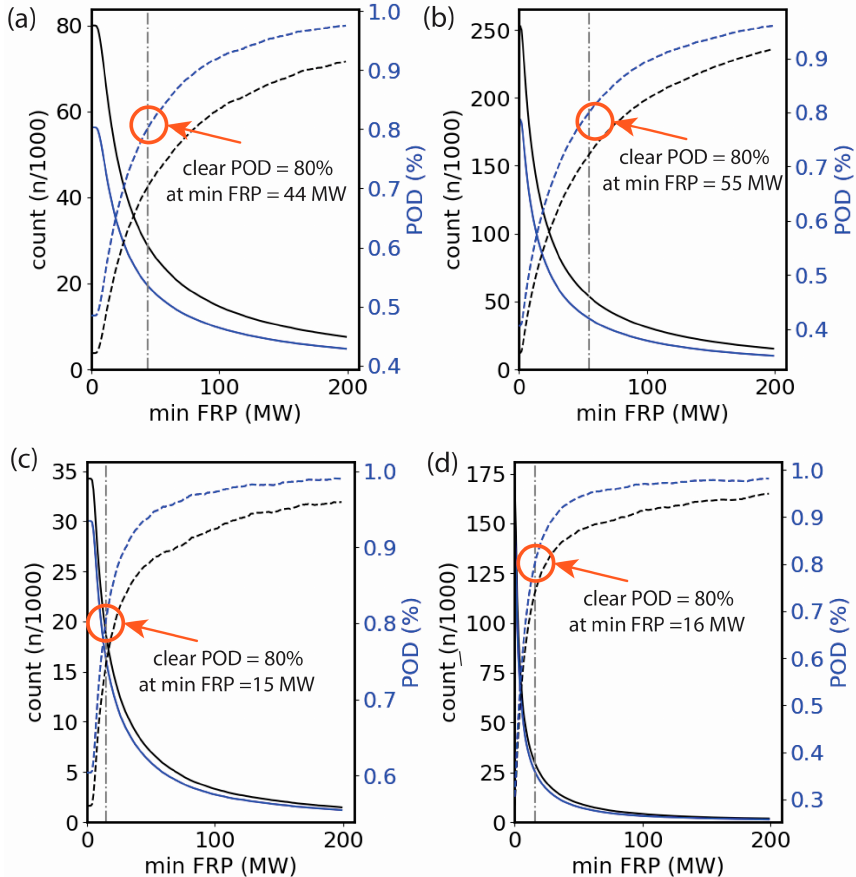
Figure 4. ( a ) BRIGHT-to-MODIS (MODIS) and BRIGHT-to-VIIRS (VIIRS) raw counts and POD values analyzed by minimum MODIS and VIIRS FRP value. Minimum FRP versus raw count (solid line) and minimum FRP versus probability of detection (dashed line, axis on right) for all MODIS daytime hotspots (black) and for the subset of “clear” values having a valid BRIGHT threshold (blue). ( b – d ) are the same except for VIIRS-day, MODIS-night, and VIIRS-night. The grey dash-dot line shows the FRP value above which the “clear” POD is greater than 80%, with the actual values annotated. Note that the x -axis has been artificially cut-off at 200 MW for demonstration purposes.